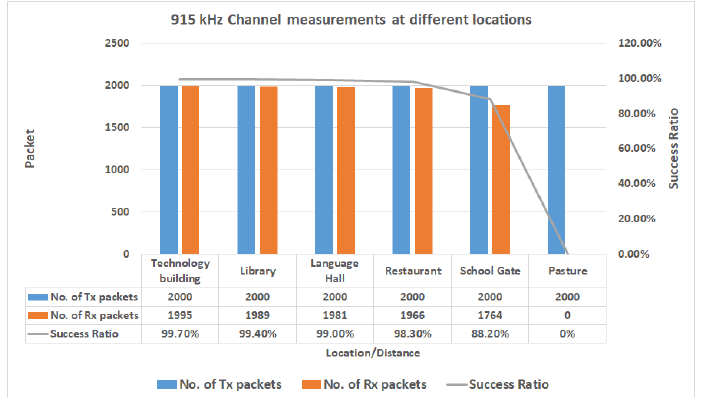
Figure 17. Receiver sensitivity data collection in the 915 kHz Channel. For minimizing the distance covered before reaching low RSSIs, the device’s broadcast power was set to the minimum (2 dBm, with a 3-dBi antenna). The distance between the logging stations and gateway when packets started to be dropped was in the order of 1400 m. Figure 19 illustrates the actual results of sensitivity receiving.